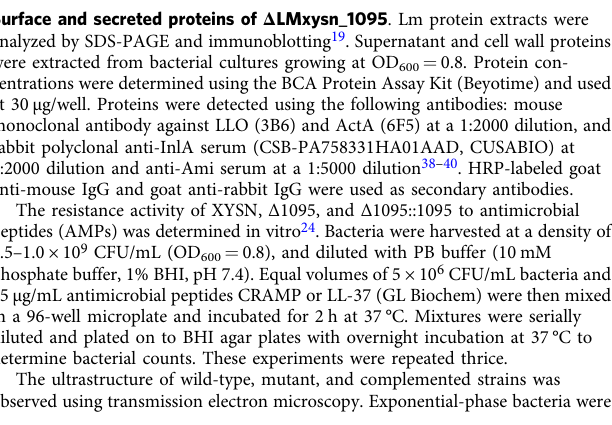
Strains expressing GFP were generated by electrotransformation plasmid pERL-3- cspl-GFP. The mutant strains XYSN Δ smcL , XYSN Δ hly were obtained using the strategy described above for the mutant strain Δ 1095. The XYSN Δ smcL Δ hly mutant was obtained by deleting the smcL from XYSN Δ hly . The positive clones were further veri fi ed by sequencing. EGD-e::pIMK2- smcL and NTSN::pIMK2- smcL recombinants were generated using the hly promoter and its signal peptide sequence to drive expression of the smcL gene. Surface and secreted proteins of Δ LMxysn_1095 . Lm protein extracts were analyzed by SDS-PAGE and immunoblotting 19 . Supernatant and cell wall proteins were extracted from bacterial cultures growing at OD 600 = 0.8. Protein con- centrations were determined using the BCA Protein Assay Kit (Beyotime) and used at 30 µg/well. Proteins were detected using the following antibodies: mouse monoclonal antibody against LLO (3B6) and ActA (6F5) at a 1:2000 dilution, and rabbit polyclonal anti-InlA serum (CSB-PA758331HA01AAD, CUSABIO) at 1:2000 dilution and anti-Ami serum at a 1:5000 dilution 38 – 40 . HRP-labeled goat anti-mouse IgG and goat anti-rabbit IgG were used as secondary antibodies. The resistance activity of XYSN, Δ 1095, and Δ 1095::1095 to antimicrobial peptides (AMPs) was determined in vitro 24 . Bacteria were harvested at a density of 0.5 – 1.0× 10 9 CFU/mL (OD 600 = 0.8), and diluted with PB buffer (10 mM phosphate buffer, 1% BHI, pH 7.4). Equal volumes of 5× 10 6 CFU/mL bacteria and 25µg/mL antimicrobial peptides CRAMP or LL-37 (GL Biochem) were then mixed in a 96-well microplate and incubated for 2 h at 37 °C. Mixtures were serially diluted and plated on to BHI agar plates with overnight incubation at 37°C to determine bacterial counts. These experiments were repeated thrice. The ultrastructure of wild-type, mutant, and complemented strains was observed using transmission electron microscopy. Exponential-phase bacteria were